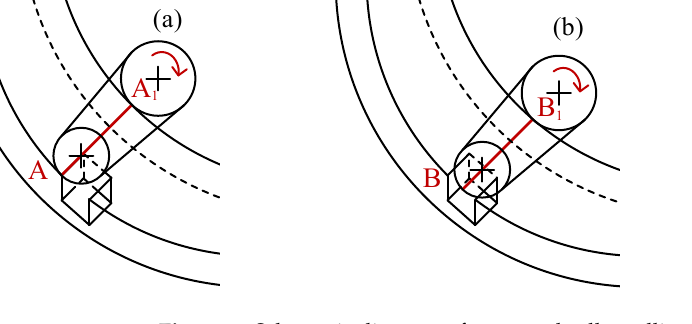
Figure 5. Schematic diagram of a tapered roller rolling over the different fault positions: ( a ) the entry edge; ( b ) the fault center; ( c ) the exit edge.